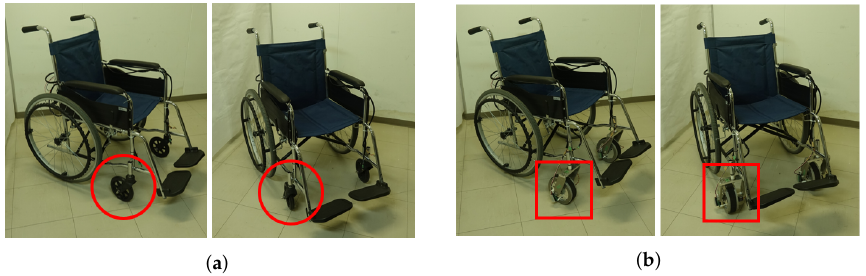
Figure 14. Realization of self-propelled wheelchair using step-ascending prototype. ( a ) Conventional general wheel; ( b ) proposed step-ascending wheel.